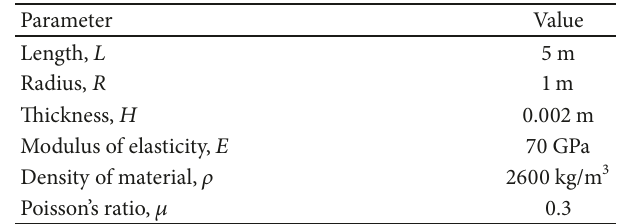
Table 2: Geometric and material parameters of the rotating thin cylindrical